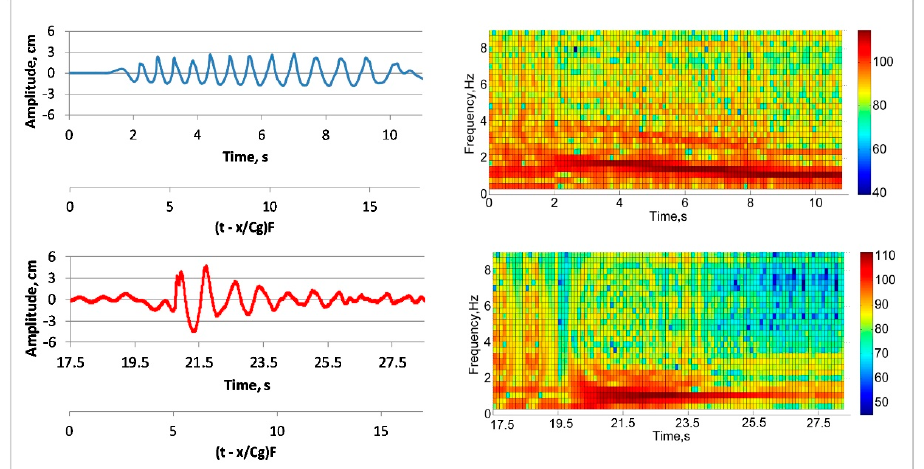
Figure 2. Temporal records of a low-frequency (LF) wave packet with linearly varying frequency near the wave maker (blue) and at a distance of 8.5 m (red) (left) and Morlet wavelet spectrograms (right). Two axes are shown: real time and non-dimensional moving coordinate ( t − x / C g ) F where t is real time, F is a mean frequency of the wave packet, C g ( F ) is a group velocity, x is a distance between the wire